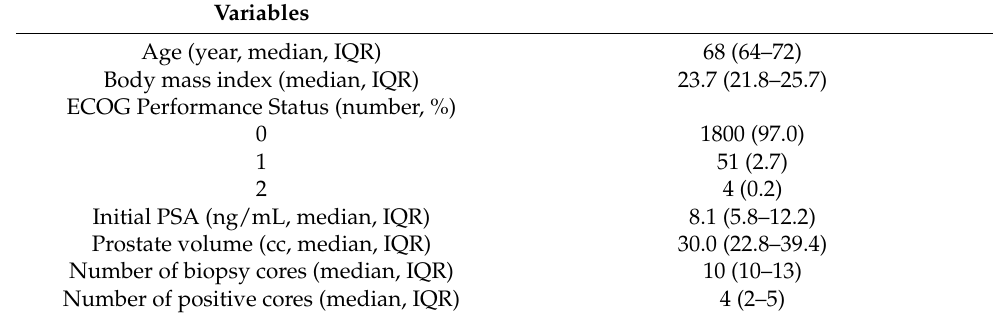
Table 1. Patient